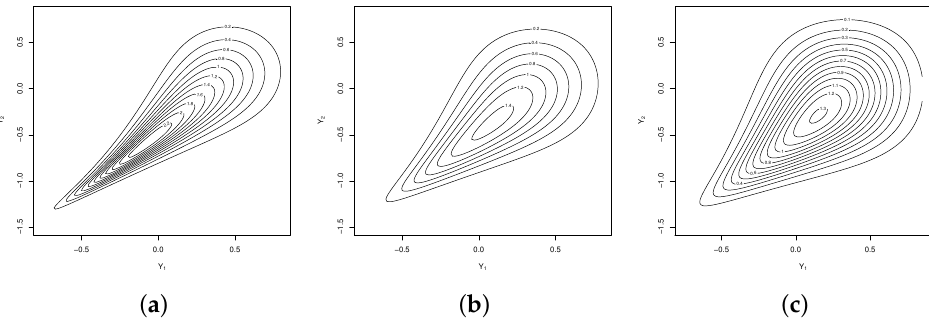
Figure 1. Density plots. ( a ) δ = 0.35, ( b ) δ = 0.70 and ( c ) δ = 1.0. Statistical